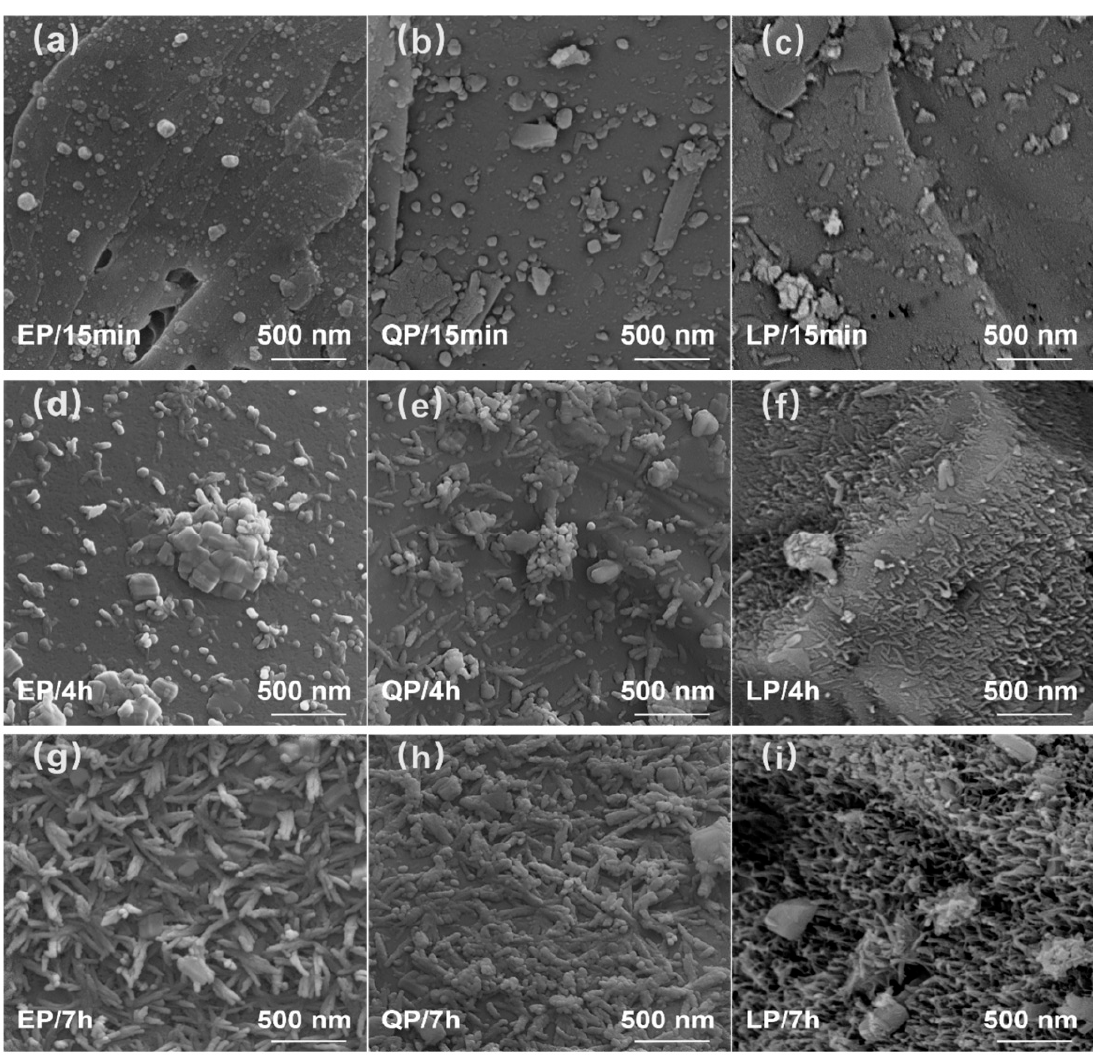
Figure 11. Morphology of hydration products on the surface of EP particle at 15 min (a), 4 h (d) and 7 h (g), QP particle at 15 min (b), 4 h (e) and 7 h (h), and LP particle at 15 min (c), 4 h (f) and 7 h (i).